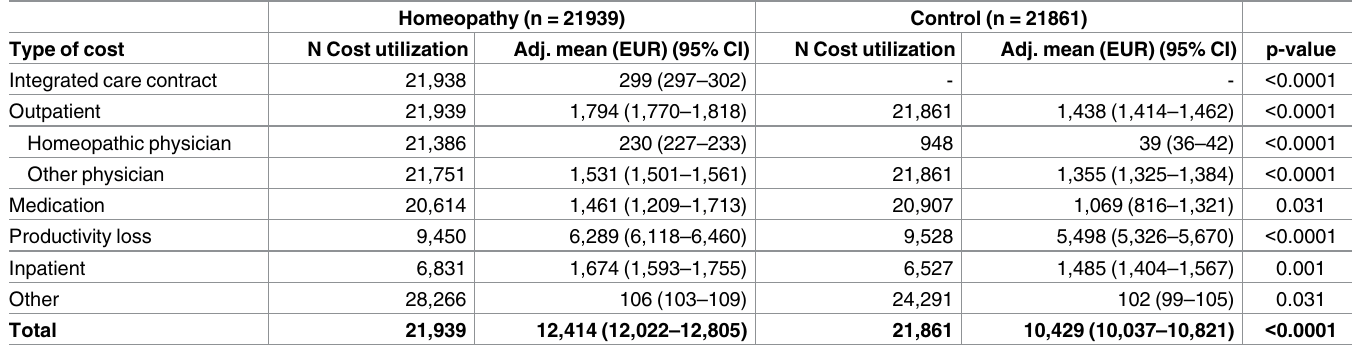
Table 2. Adjusted means for different cost types over 33 months after the start of the integrated care contract for all patients, societal